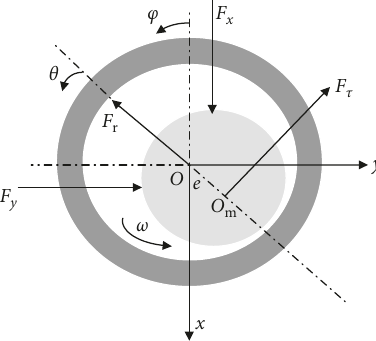
Figure 2: Schematic diagram of journal bearing.